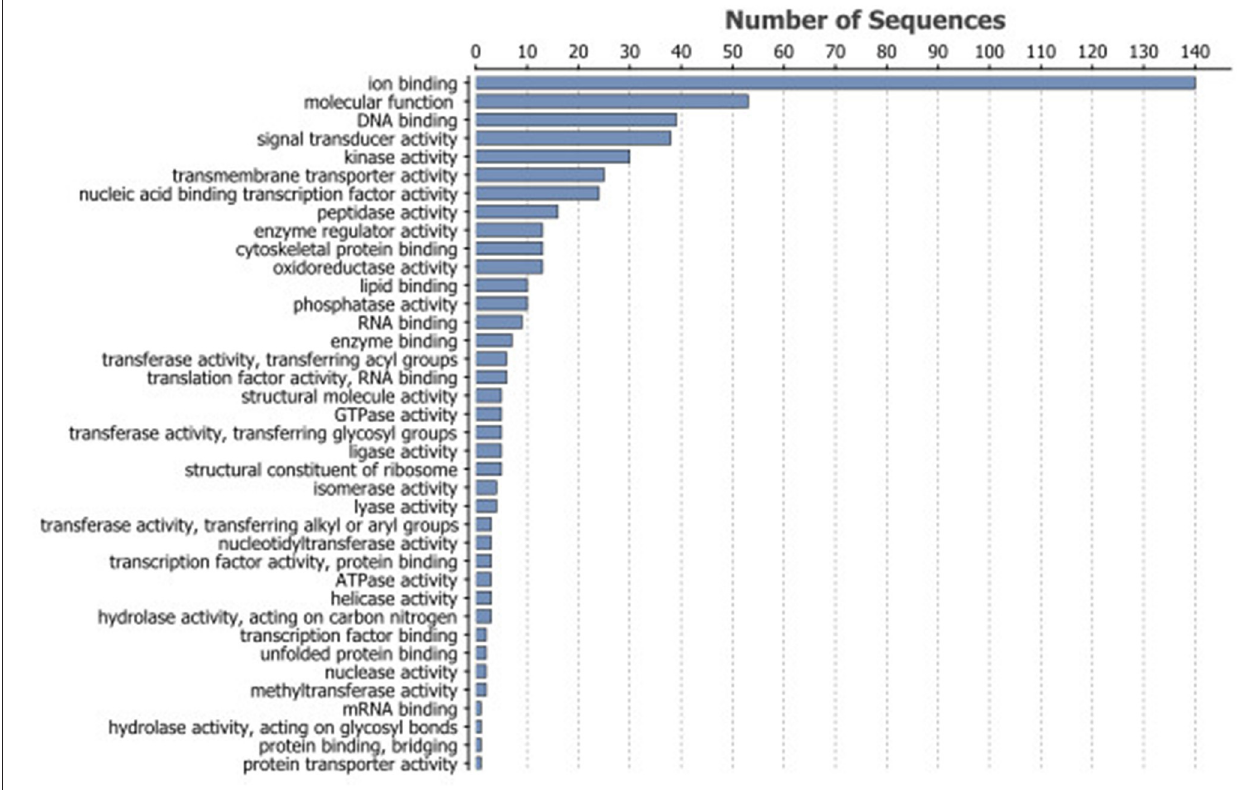
levels in rainbow trout vary with season, showing high levels in summer (May to October) and low levels in winter (December to May) (Koldkjaer et al., 2004). Although β 3 b -ar mRNA